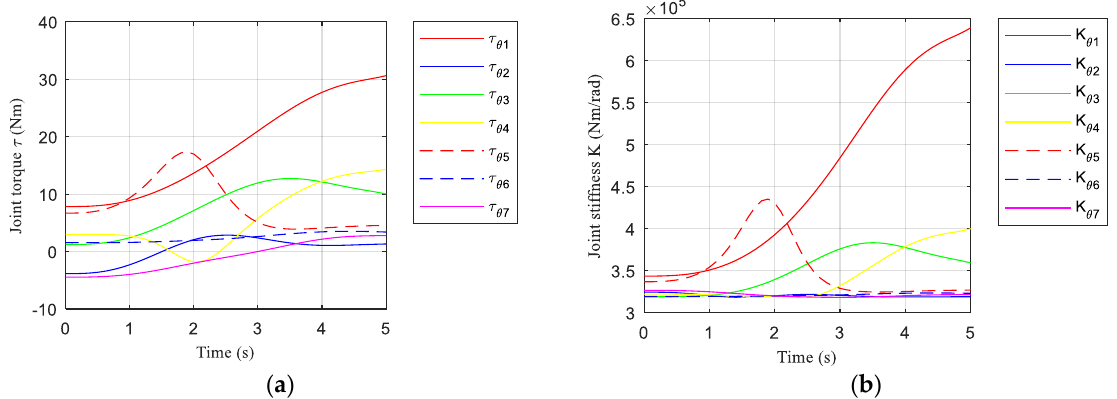
Figure 7. The real-time joint torque and joint stiffness of each joint of the humanoid manipulator. ( a ) The real-time joint torque; ( b ) The real-time joint stiffness.